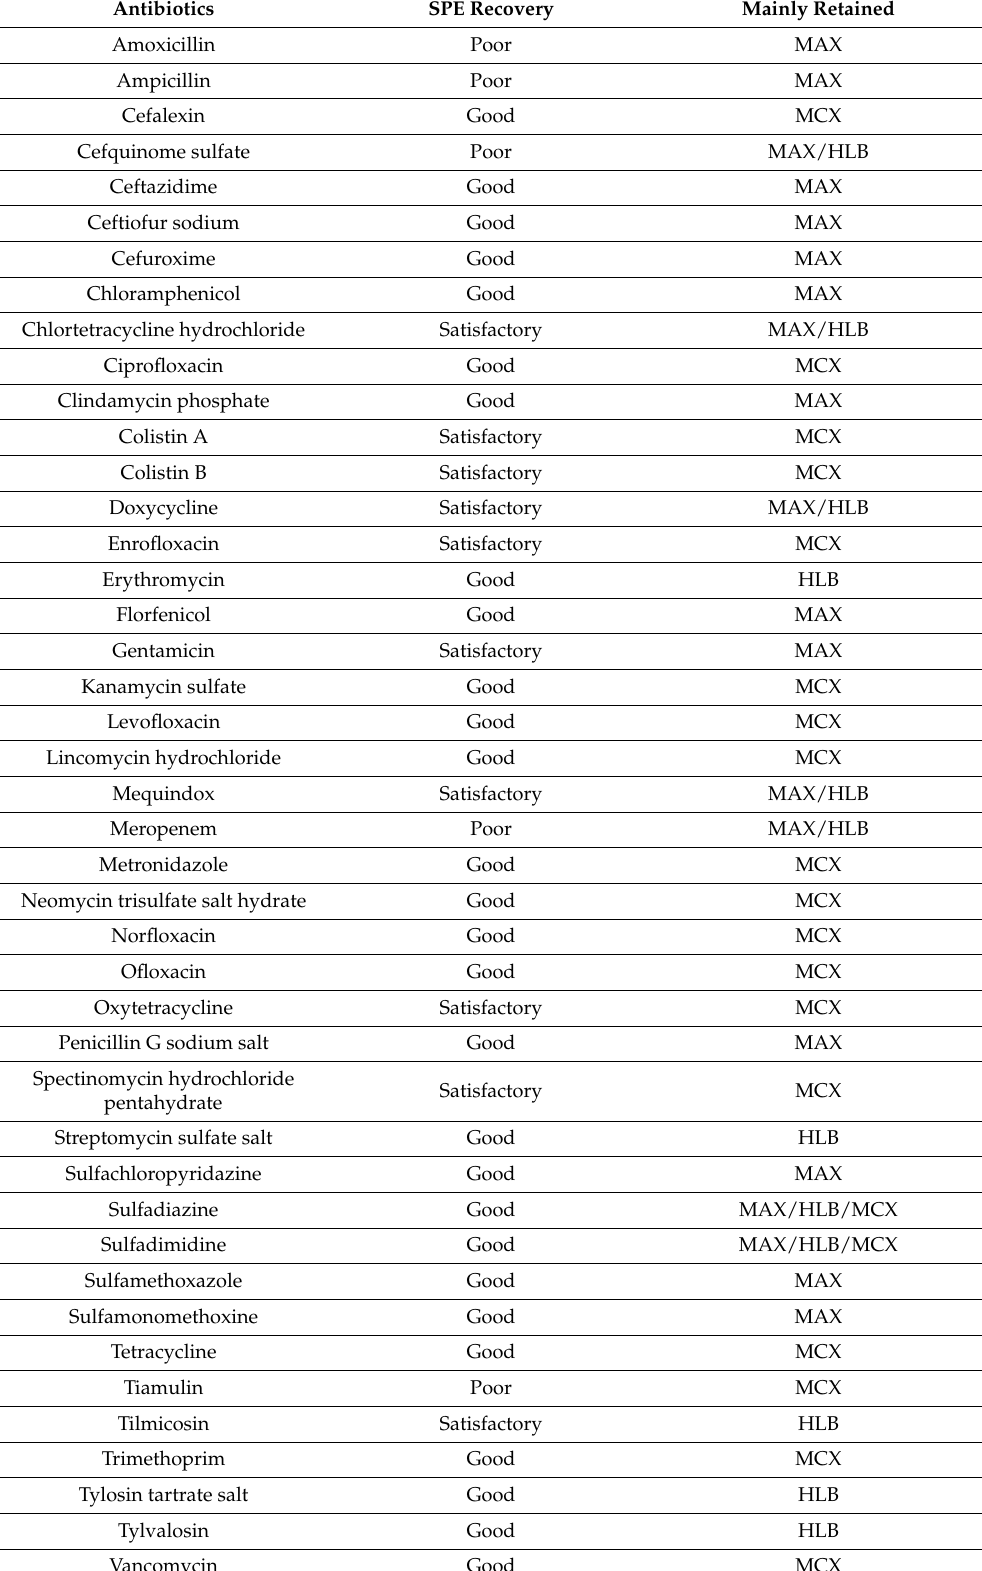
Table 3. Solid-phase extraction of 43 antibiotics